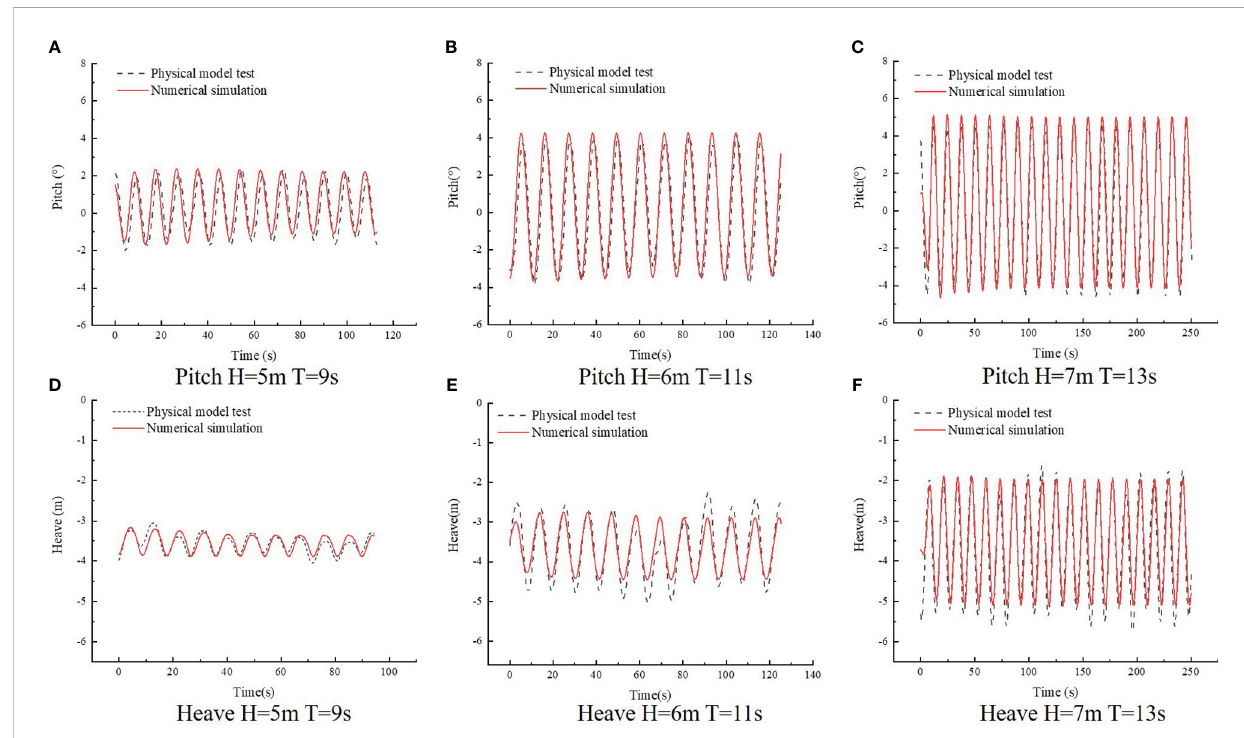
FIGURE 8 Comparison of motion responses between physical model test and numerical simulation under different wave